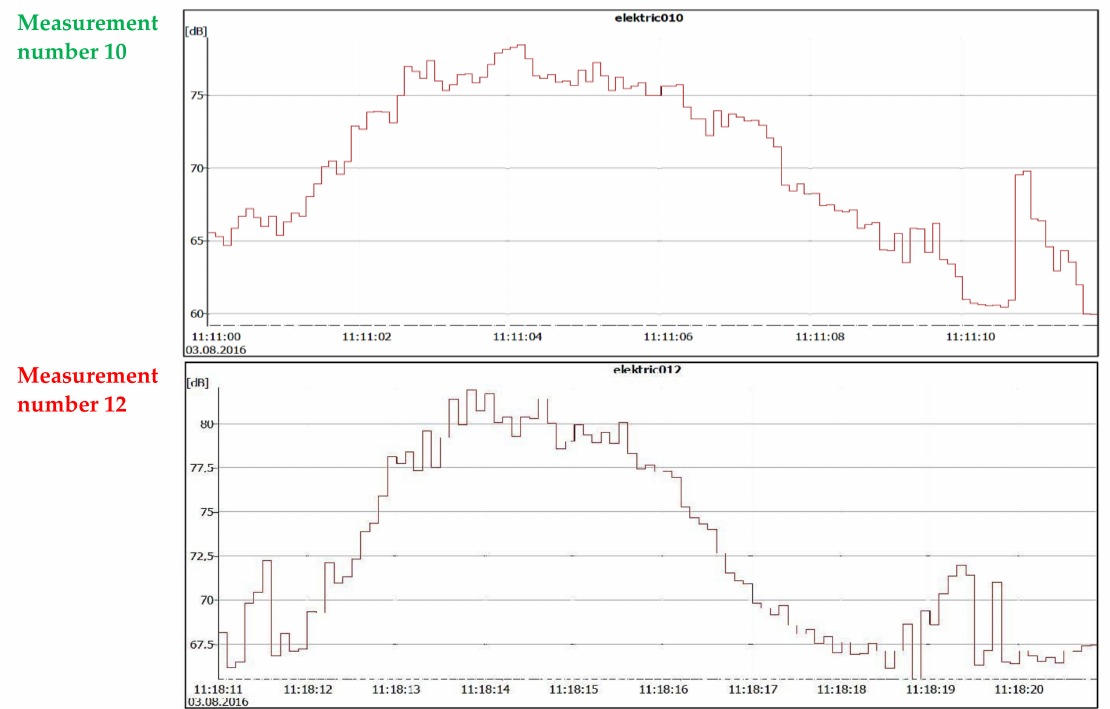
Figure 9. Time history of values of noise levels L Aeq of selected